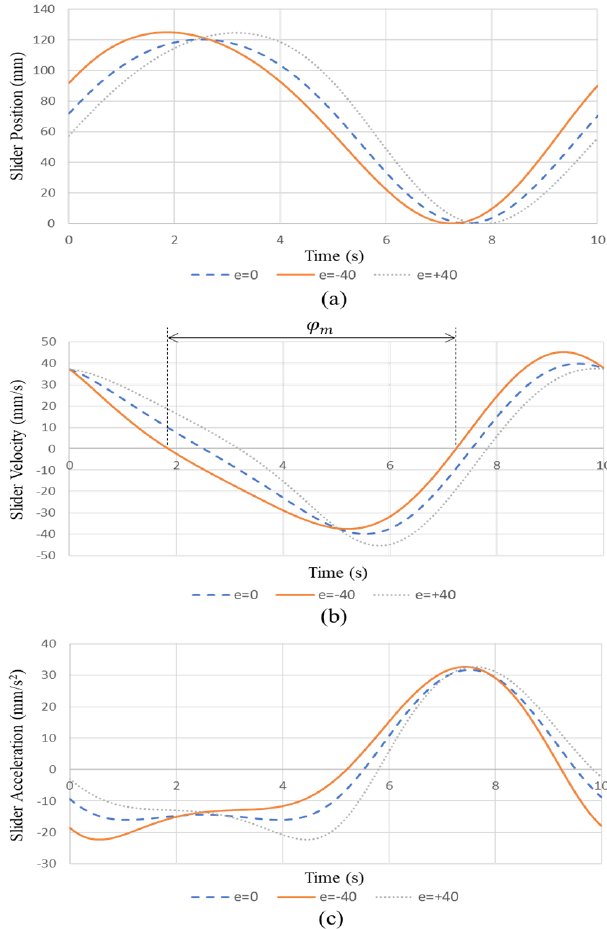
slider points are shown for each eccentricity, their start and end points are different as given in Fig. 7a.